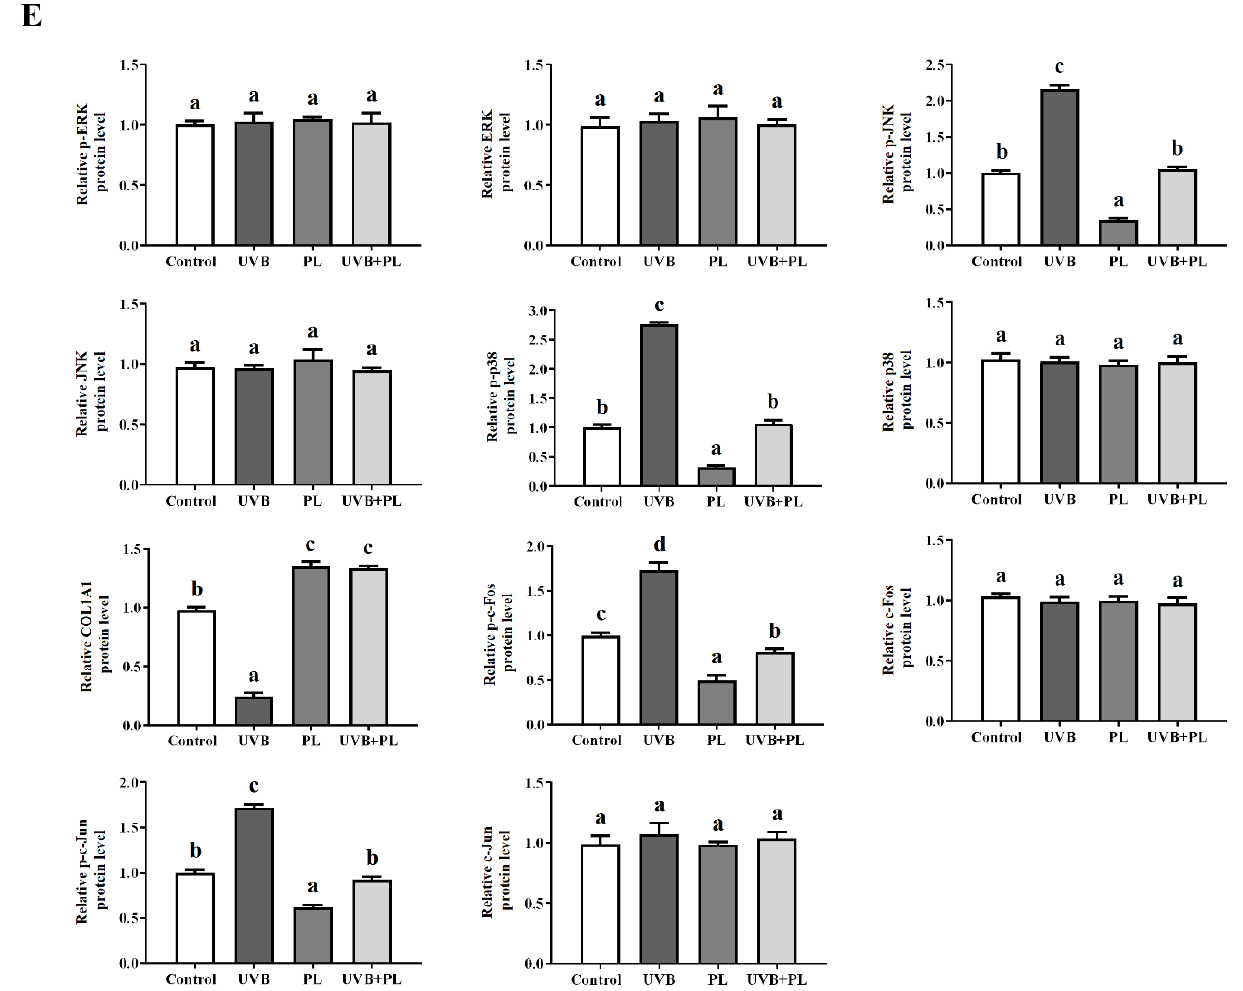
Figure 5. Effects of PL on wrinkles formation-related parameters in NHDF cells: ( A ) Type I collagen content; ( B ) The relative mRNA levels of MMPs; ( C – E ) The relative protein levels of p-MAPKs, MAPKs, COL1A1, p-AP-1s, AP-1s; Results are expressed as the mean ± SD ( n = 3). Differences among the variables were assessed using Duncan’s multiple range tests. Values having different letters are significantly different ( p < 0.05).